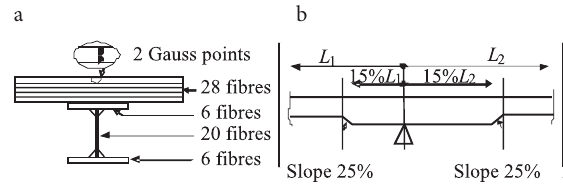
Fig. 2. Cross-section integration (a); variable inertia (b)